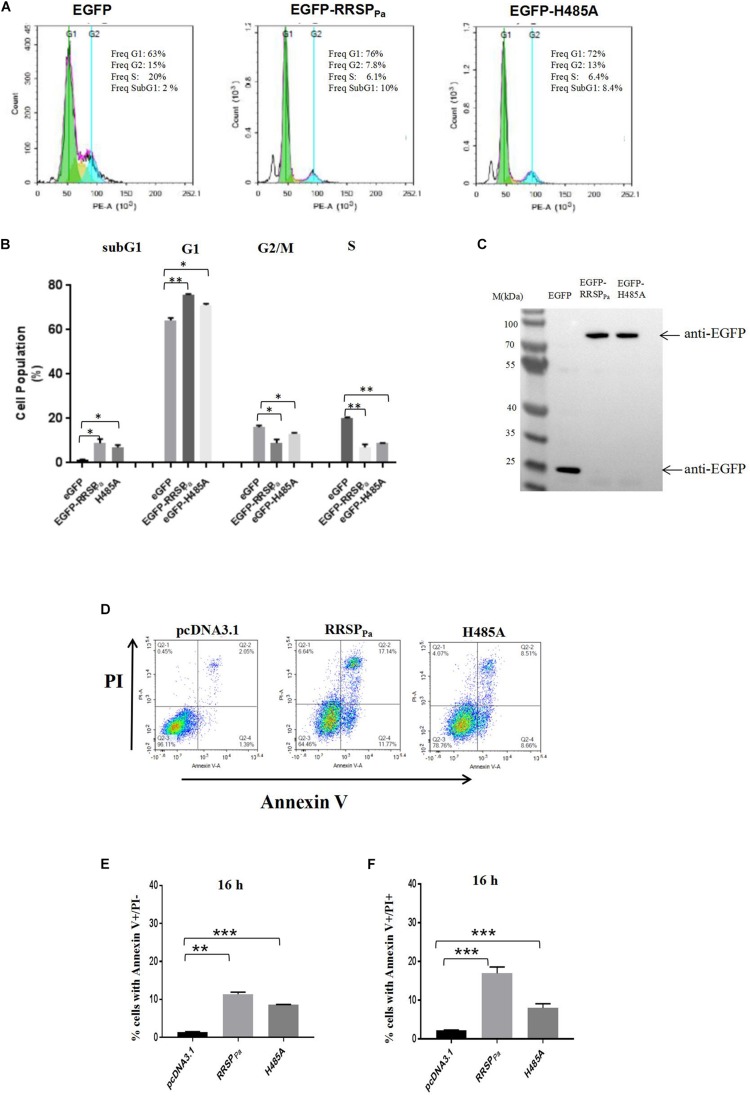
RRSPPa alters cell cycle distribution and increases apoptosis and cell death. (A) Representative cell cycle images of HeLa cells after transfection. HeLa cells transfected with pEGFP-RRSPPa, pEGFP-H485A, and pEGFP was used as a negative control. The cell cycle was analyzed by flow cytometry 16 h post-transfection. (B) The average percentage of cells in the cell cycle phases summarized from three biological replicates. (C) The expression levels of the EGFP, EGFP-RRSPPa, and EGFP-H485A were detected through Western blot with primary GFP antibody. (D) Flow cytometric analysis of cells stained with Annexin V and PI. As identified by flow cytometry, cells were divided into four sections: upper left quadrant: Annexin V-/PI +, representing the mechanical error; upper right quadrant: Annexin V + /PI +, representing the late apoptosis or necrosis cells; lower left: Annexin V-/ PI-, representing the living cells; lower right quadrant: Annexin V + / PI-, representing the early apoptosis cells. (E) The percentage of cells with Annexin V + /PI-staining at 16 h. (F) The percentage of cells with Annexin V + /PI + staining 16 h. The data are presented as the mean and standard deviation from three independent experiments, and t-test was conducted for statistical analysis. *P < 0.05; **P < 0.01; ***P < 0.001.